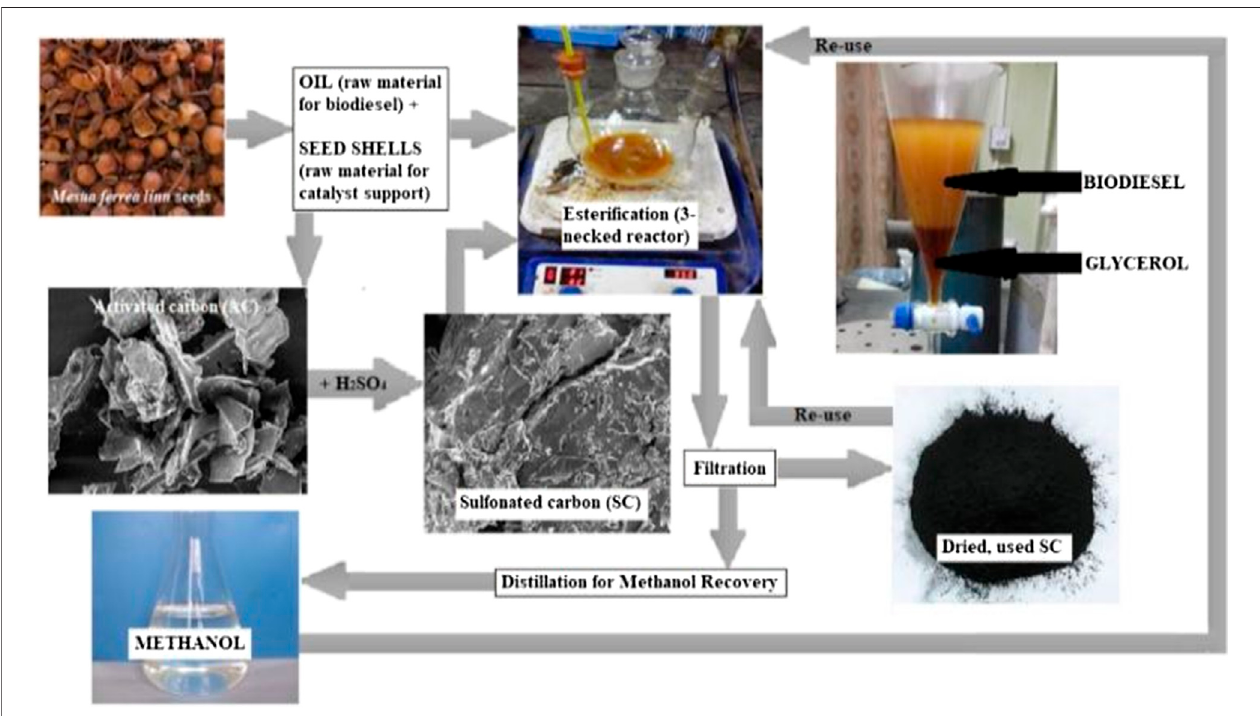
FIGURE 1 | Process fl ow diagram for biodiesel production using MFL seed shell